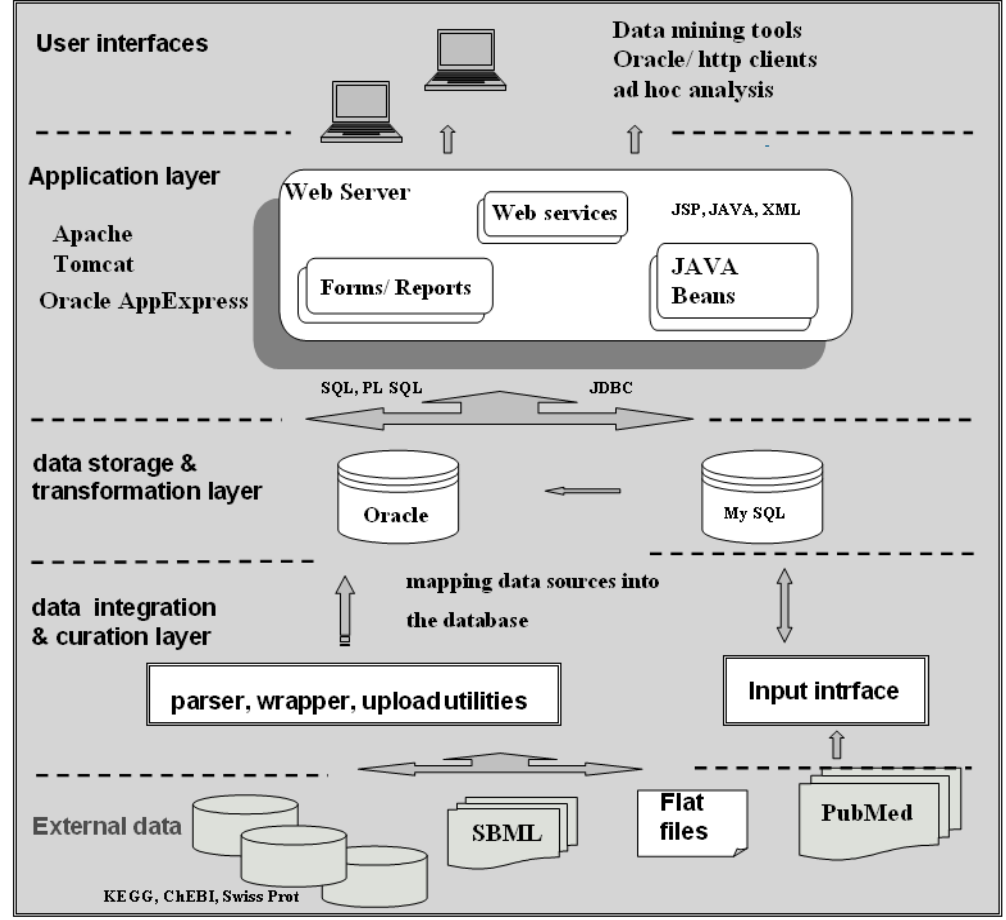
Figure 2. Detailed architecture of the system components and data workflow